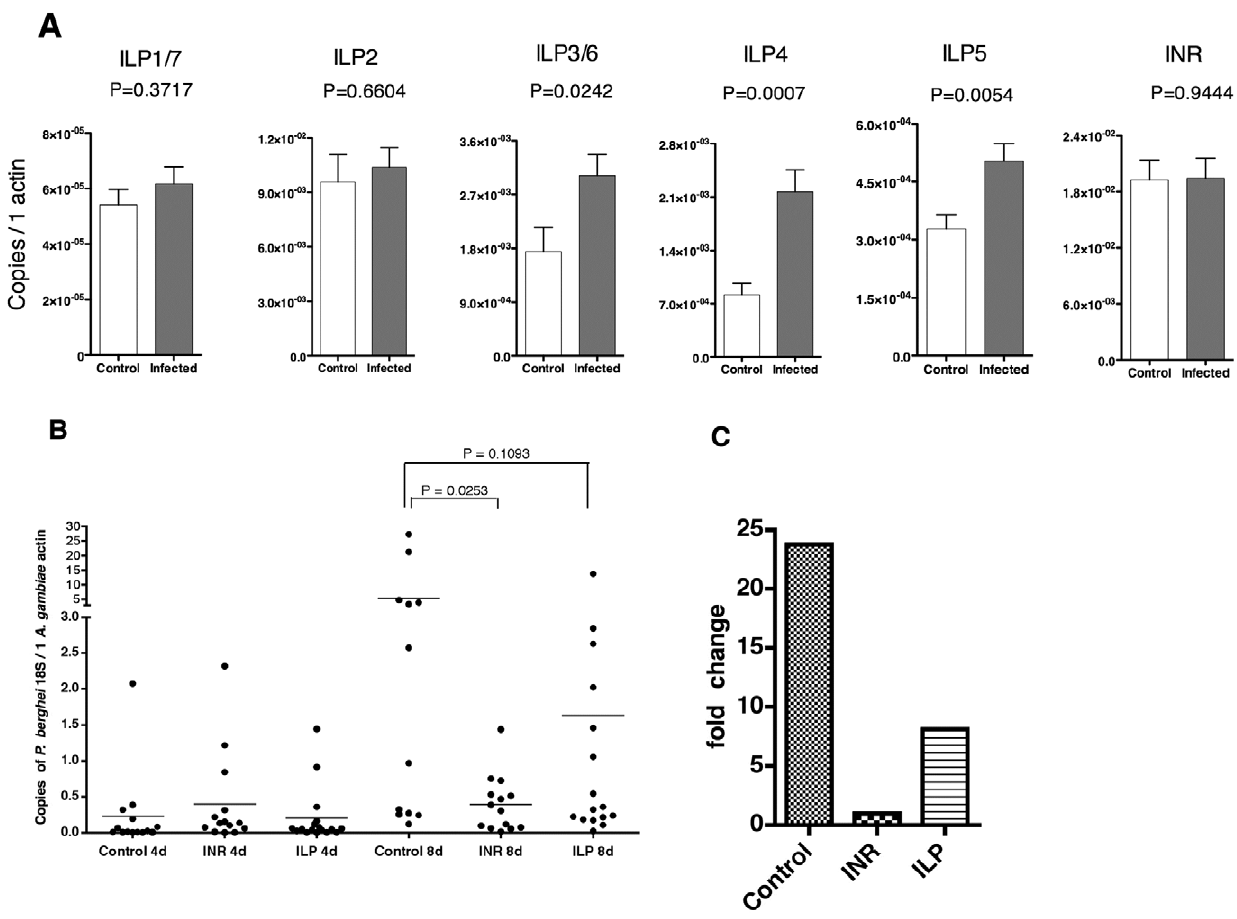
Figure 5. Role of insulin-like signaling in Anopheles mosquitoes during Plasmodium infection. ( A ) Expression of insulin-like peptides (ILPs) and insulin receptor (INR) gene in P. berghei -infected A. gambiae at 13 dpi. The expression levels were determined by compared to the expression level of A. gambiae actin gene. Error bars indicate standard deviation and P values were analyzed by t -test. ( B ) Knocking down insulin-like signaling interferes with Plasmodium development in the mosquitoes. dsRNA against INR or ILP3/6, 4, 5 (pooled) were injected into P. berghei -infected A. gambiae at 5 dpi. dsRNA for EGFP were infected as the control. 4 and 8 days after dsRNA injection, the level of P. berghei load at the mosquitoes were quantified by qRT-PCR. Each dot represents the P. berghei 18S rRNA load in one mosquito normalized to A. gambiae actin gene. Bars indicate mean values and P values were analyzed by Mann-Whitney test. ( C ) Fold changes of P. berghei load in the mosquitoes were compared between 4 and 8 days post dsRNA injection.